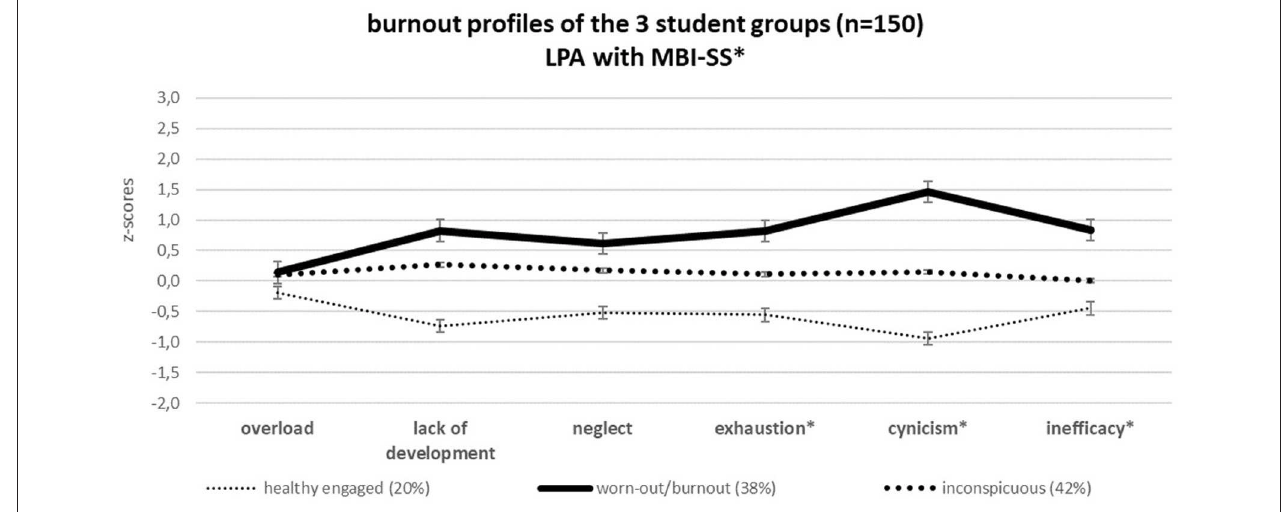
FIGURE 6 | Burnout characteristics of the three MBI-SS classes in the stressed